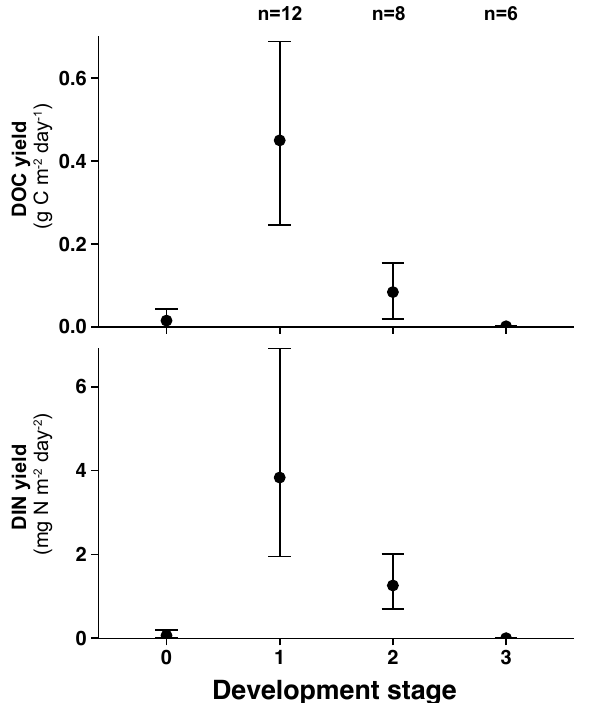
Figure 8. Geometric mean (SE) of dissolved organic carbon and dissolved inorganic nitrogen yield for thermokarst features in dif- ferent development stages. Yield was calculated by difference in concentration above and below thermokarst feature multiplied by discharge and divided by feature area. Reference yields (stage 0) are maximum, minimum, and mean estimates from the literature for Arctic tundra (Giesler et al., 2014; McClelland et al., 2007; Mc- Clelland et al., 2014; Olefeldt et al., 2013; Peterson et al., 1993; Peterson et al., 1986; Townsend-Small et al., 2011). See Table 1 for complete definition of development stages: 0, reference; 1, most active; and 3, stabilized.